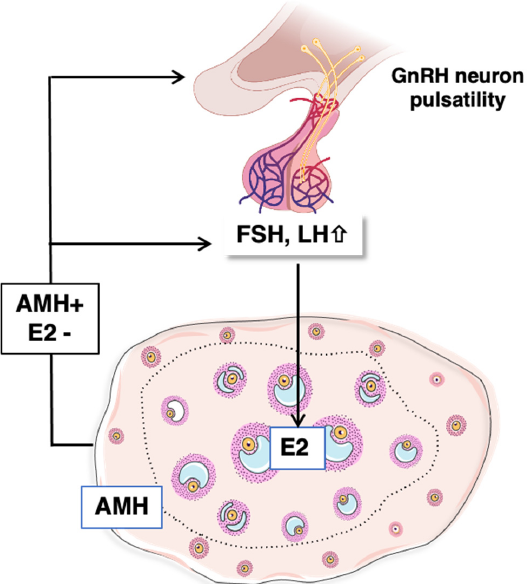
Figure 5. Proposed hypothesis on the dialogue between the ovary and the hypothalamo-pituitary system at mini-puberty. Estradiol produced by the first follicular waves may exert a negative feedback loop on the hypothalamus to restrain gonadotropin synthesis and secretion; however, the high levels of AFP may still limit its action. In contrast, we hypothesize that AMH produced by the subsequent follicular waves may up-regulate FSH synthesis by the pituitary and possibly LH and FSH levels by acting on GnRH neurons in the hypothalamus. See references in the text.